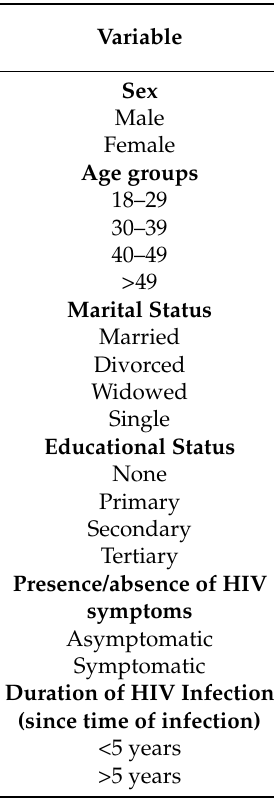
Table 1. Socio-Demographic